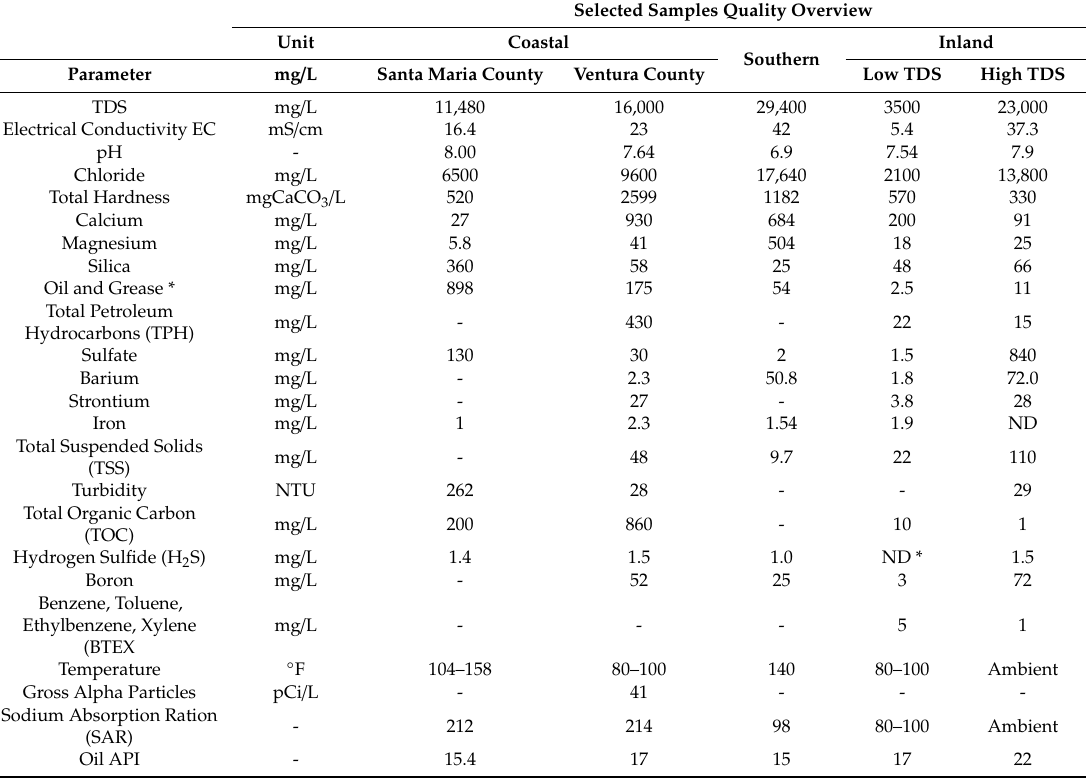
Table 1. Detailed produced water qualities from select fields across di ff erent regions of